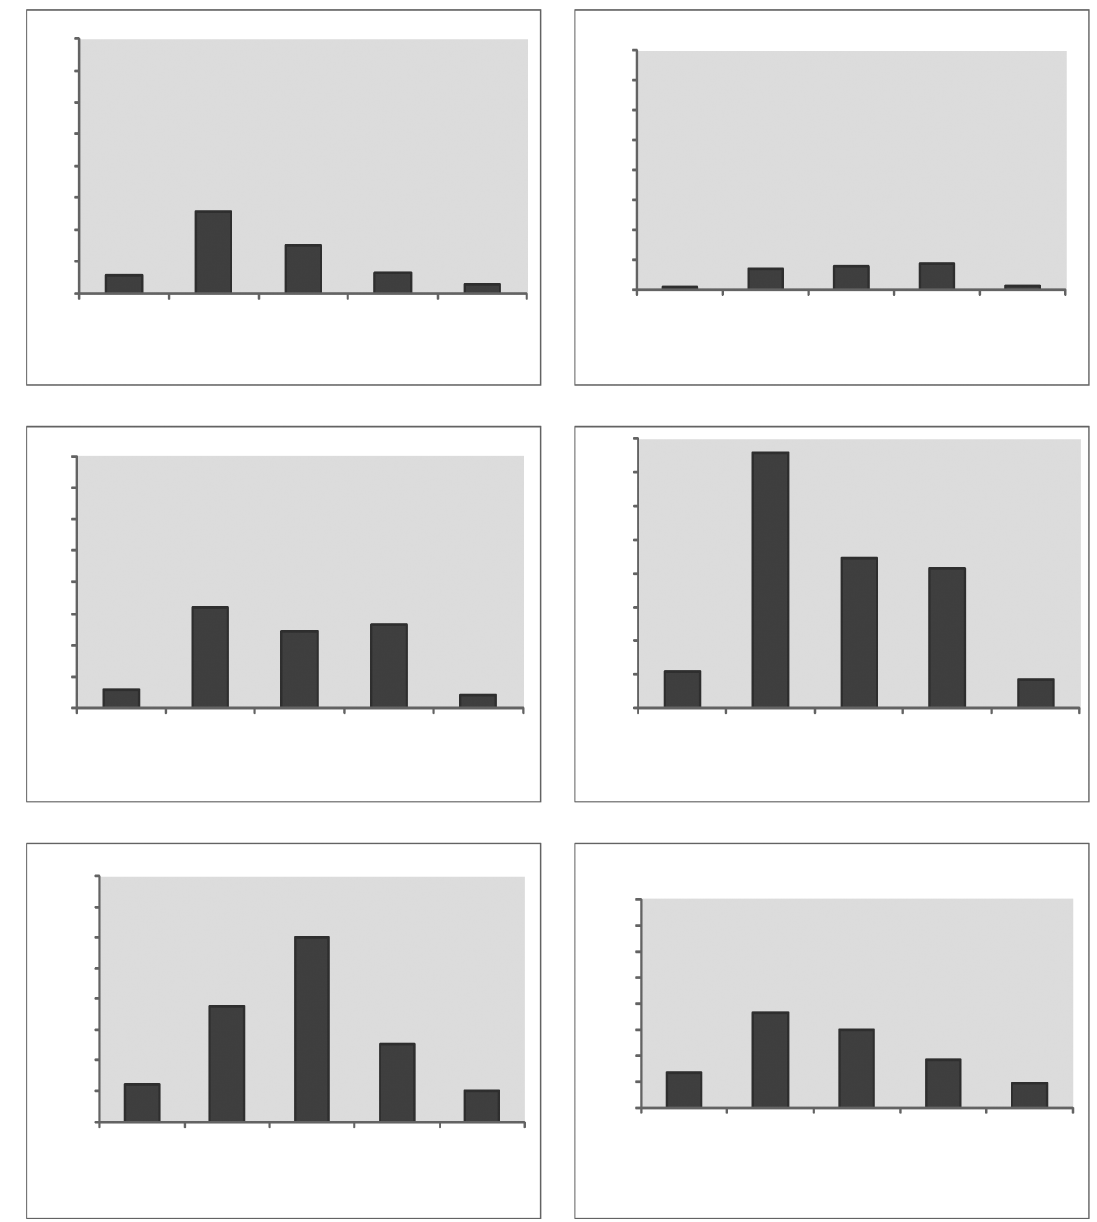
Figure 2. Annual low cloud distribution in the six major climatic zones of